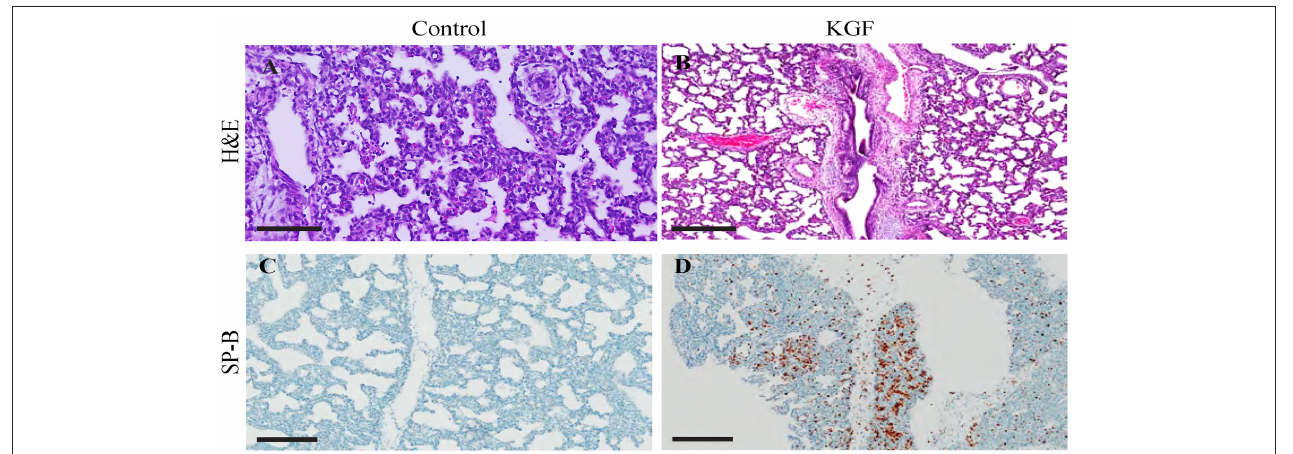
FIGURE 3 | Immunohistochemistry performed on lung sections collected after 24 h of mechanical ventilation. (A,B) Hematoxylin and eosin (H&E)-stained sections show increased areas of inflammatory cells infiltration, edema, areas of atelectasis in control lungs compared to those in KGF lungs ( Table 3 , * p < 0.05) (C,D) Surfactant protein B (SP-B) expression is significantly higher in KGF pretreated lung tissue than in control lung tissue (19.4 ± 2.76 vs. 11.88 ± 2.30, p < 0.05). Scale bars in (A,B) are 300 µ m. Other scale bars are 200 µ m.